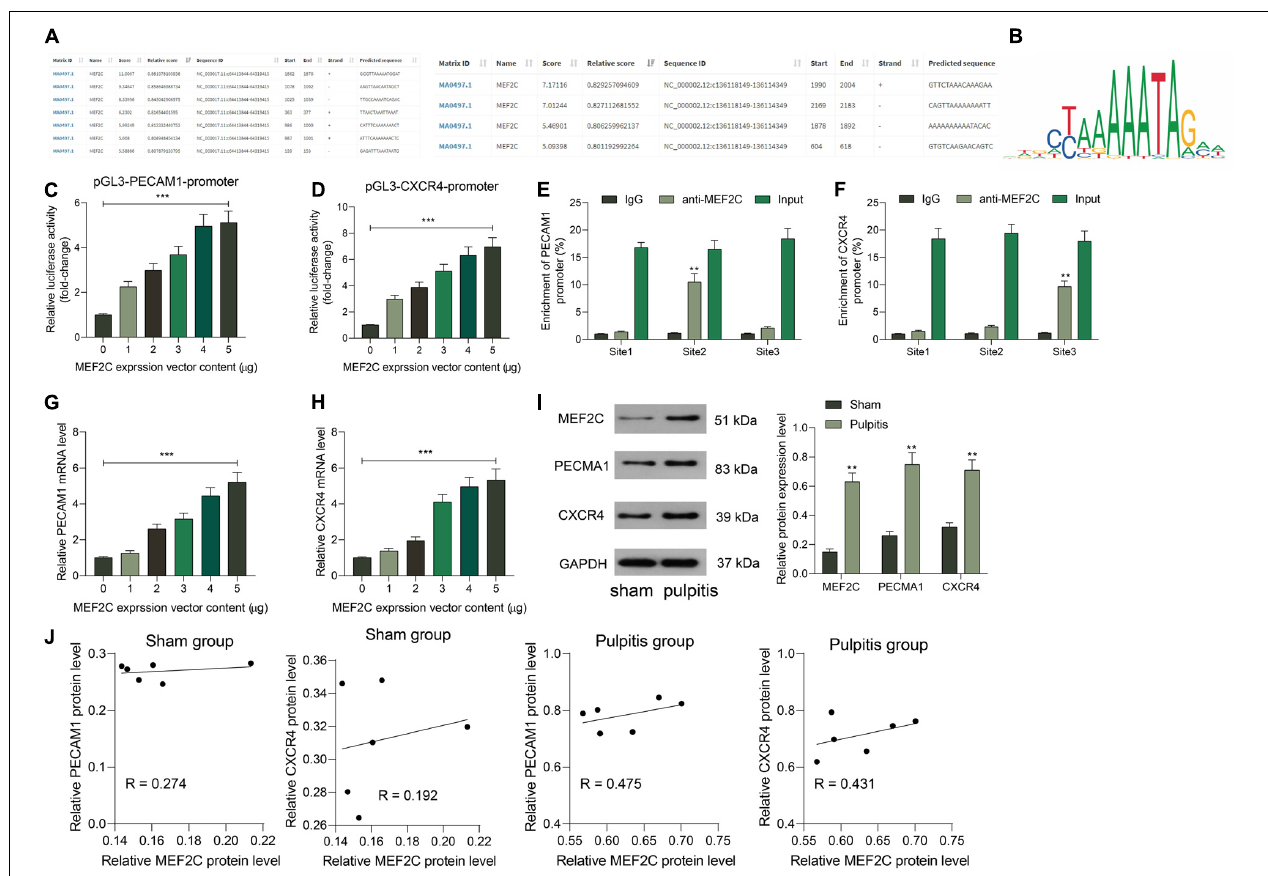
FIGURE 5 | MEF2C promotes transcription activity of PECAM1 and CXCR4. (A,B) Binding relationships between MEF2C and the promoter of PECAM1 and CXCR4 predicted on JASPAR. (C,D) Binding relationships between MEF2C and PECAM1 and CXCR4 validated through luciferase reporter gene assays. (E,F) Binding relationships between MEF2C and PECAM1 and CXCR4 validated through ChIP-qPCR assays. (G,H) Overexpressing vector of MEF2C was administrated in HDPFs, and the mRNA (G) and protein (H) expression of PECAM1 and CXCR4. I, protein levels of MEF2C, PECAM1, and CXCR4 in rat dental pulp tissues examined by western blot analysis. (J) Ccorrelation between the protein expression of MEF2C and PECAM1 and CXCR4 in rat dental pulp tissues. Data were collected from three individual experiments and expressed as mean ± SD. Data were analyzed by one-way (C,D,G, and H) or two-way ANOVA (E,F, and I) followed by Tukey’s multiple comparison test. *vs. 0 µ g of MEF2C vector, anti-IgG or sham group, ** p < 0.01, *** p <